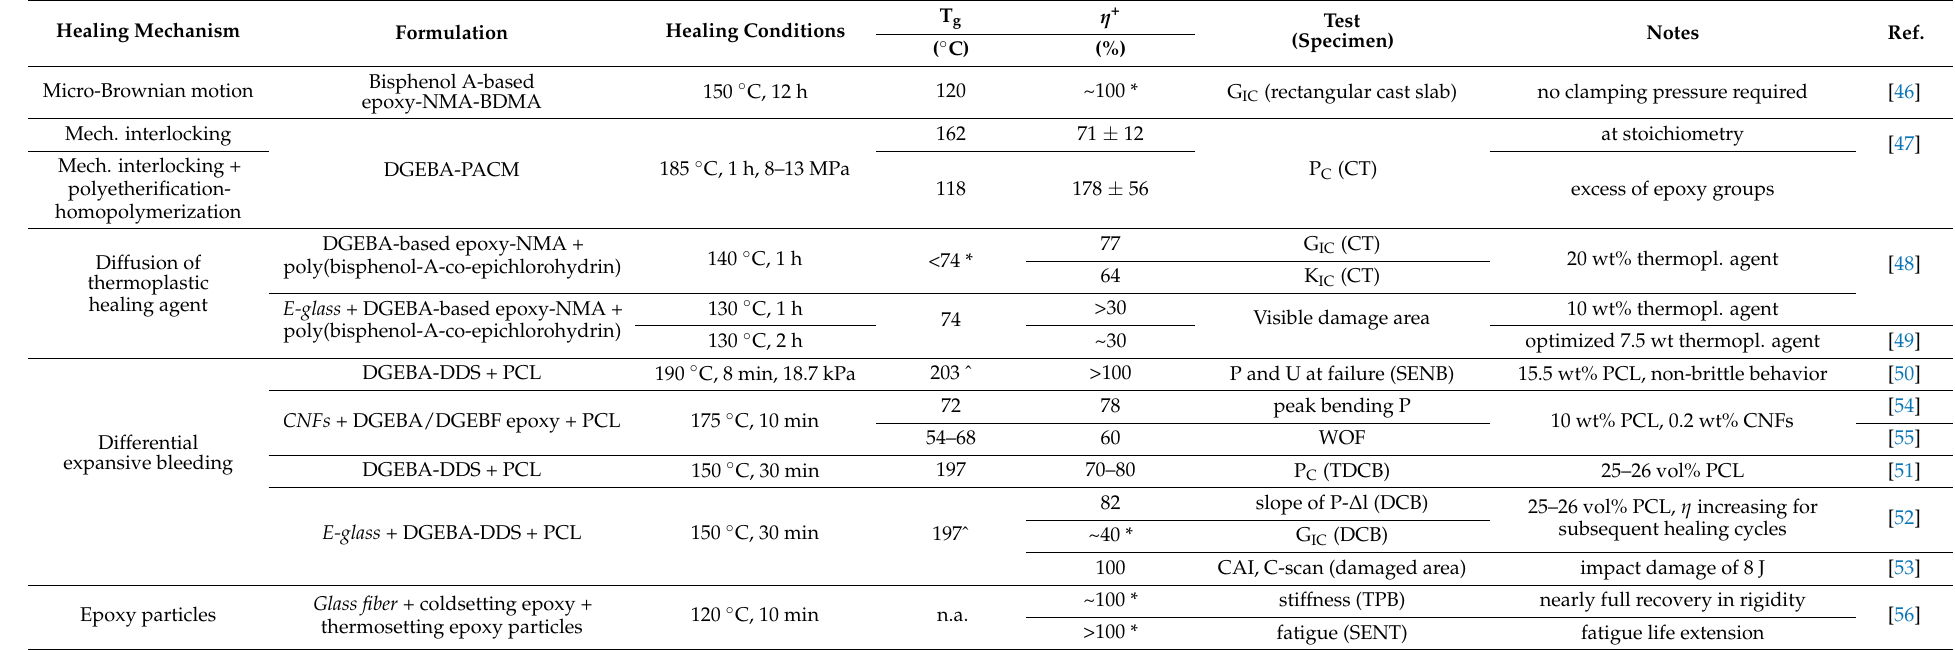
Table 2. Summary of intrinsic self-healing formulations via physical